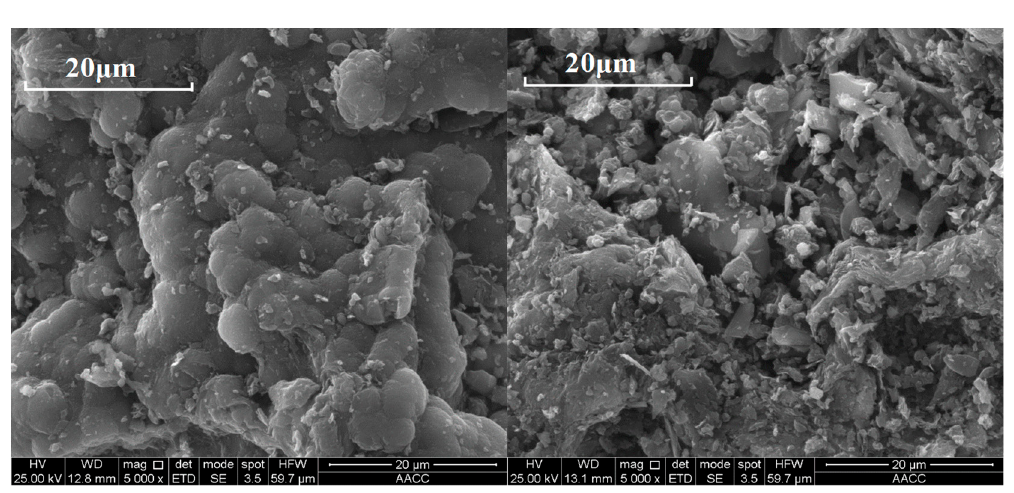
Figure 3. Surface morphologies of the coke powder determined by scanning electron microscopy (SEM).